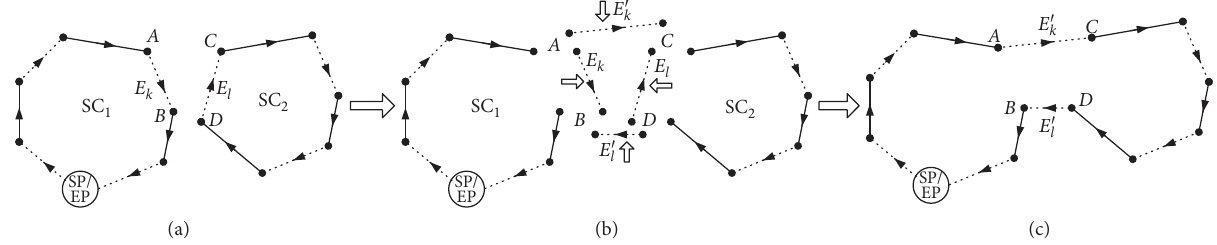
Figure 5: Process diagram of subloops merging. (a) Examples with subloops. (b) Merging scheme of subloops. (c) Loop formed with Table 2: An example of the optimal solution of TSP obtained by minimum cost merging.